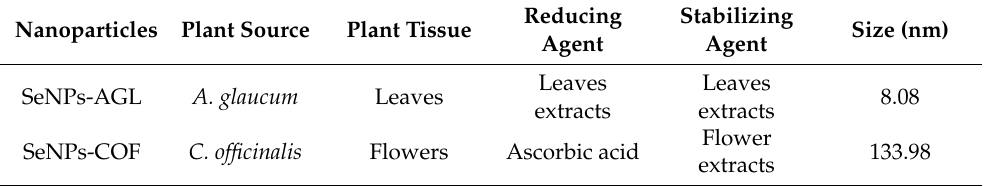
Table 2. Size of selenium nanoparticles (SeNPs) synthesized with extracts of different plant species. Nanoparticles Plant